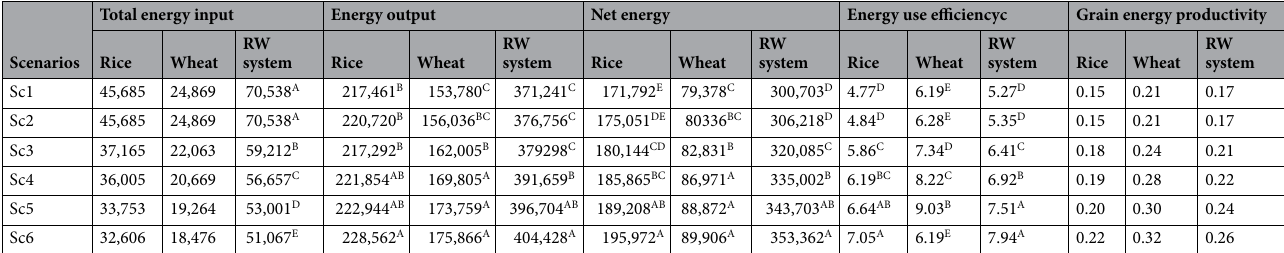
(Table 2). The contrast effects were significant to renewable & non-renewable energy (Table S2). Present study indicated that conventional RW production system in the IGP plains are mostly dependent on non-renewable